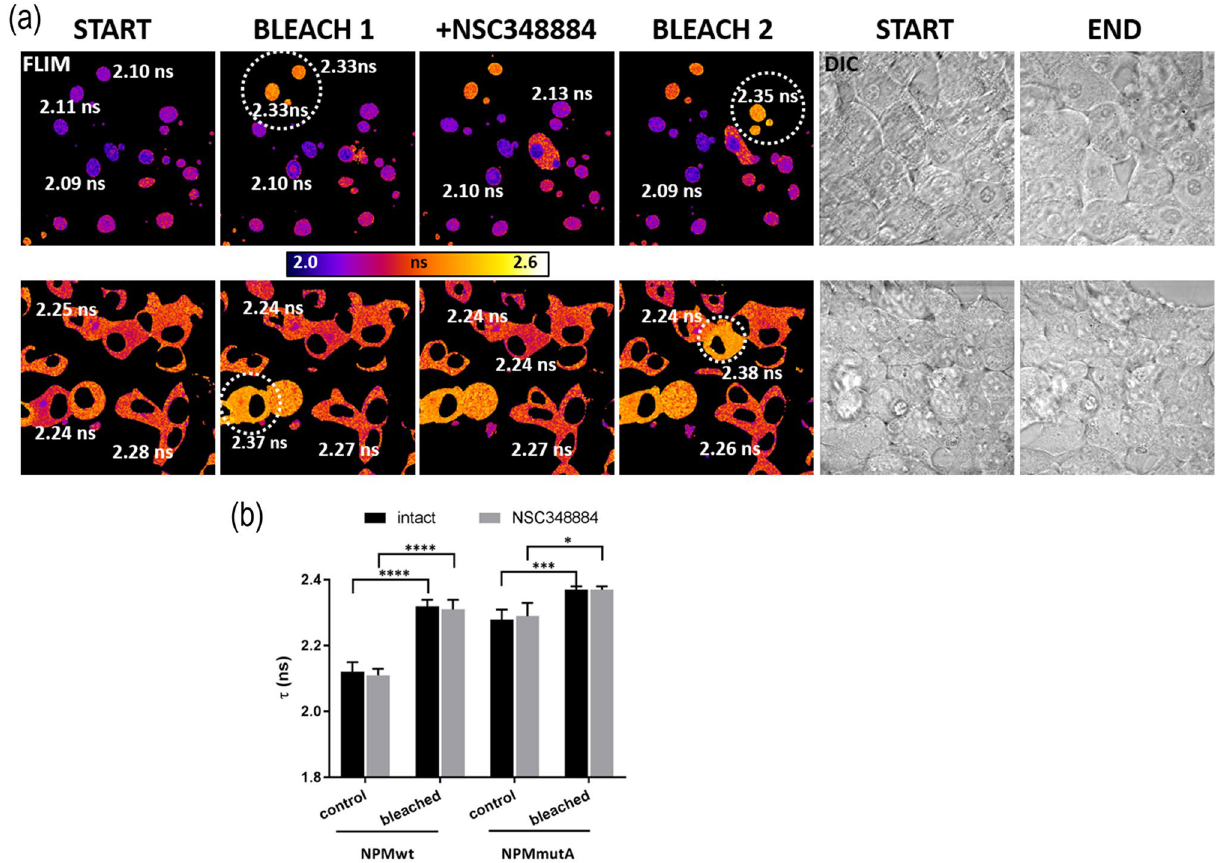
Figure 12. NPM oligomerization after NSC348884 treatment in living cells. ( a ) FLIM-FRET analysis of the eGFP-fluorescence lifetime ( τ ) after 2 h of 10 µM NSC348884 action on cells co-transfected with red and green variants of NPMwt (upper row) or NPMmut (lower row). White numbers: fluorescence lifetime measured in individual cells. Dashed circles: region of mRFP1-photobleaching. Simultaneous cell morphology screening by DIC documents cell rounding induced by NSC348884. ( b ) Statistical evaluation of τ values before (control) and after (bleached) the mRFP1 photobleaching in intact (black bar) and NSC348884-treated (grey bar) cells.